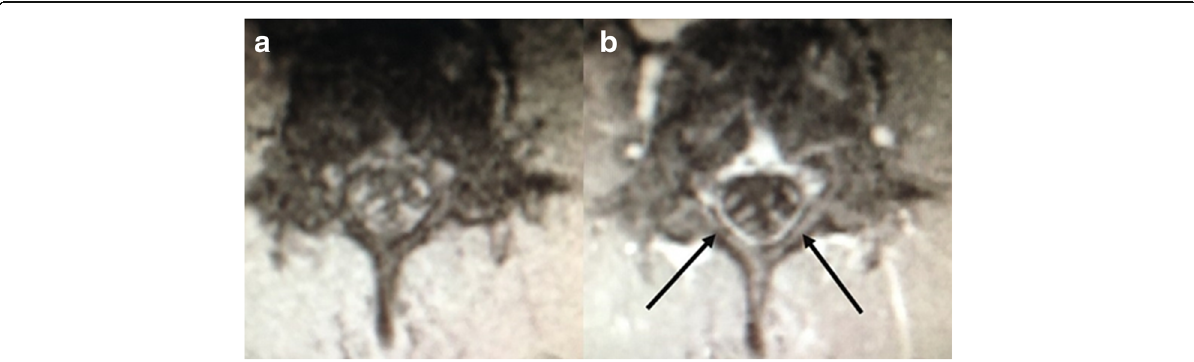
Fig. 1 MRI. Transverse section of the L4 vertebral area. a Unenhanced fat-suppressed T1-weighted image. b Gd-contrast enhanced fat-suppressed